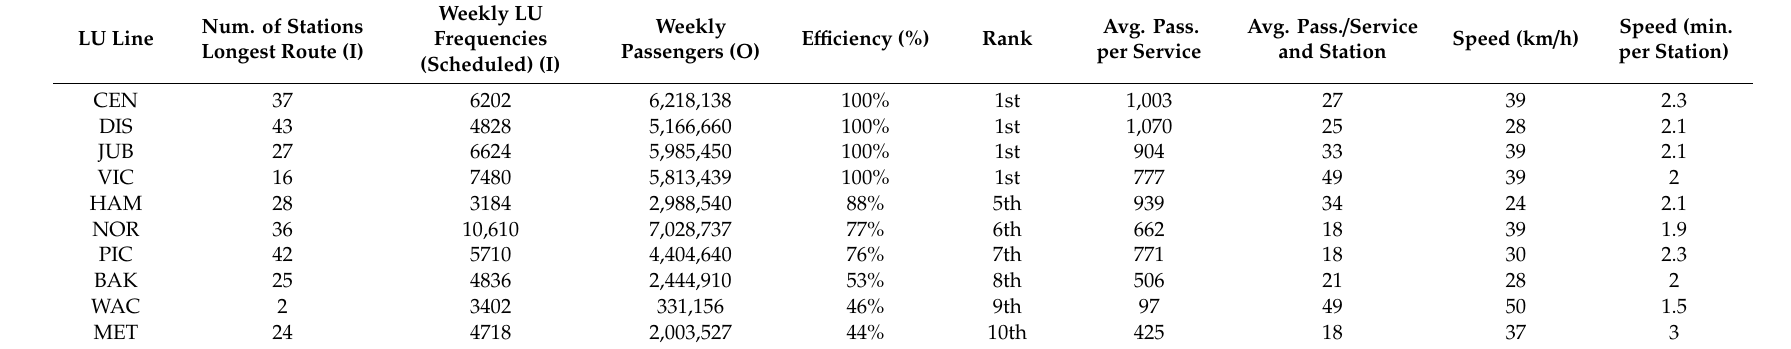
Table 8. Results of the URT lines DEA model of LU lines in descending order of e ffi ciency.